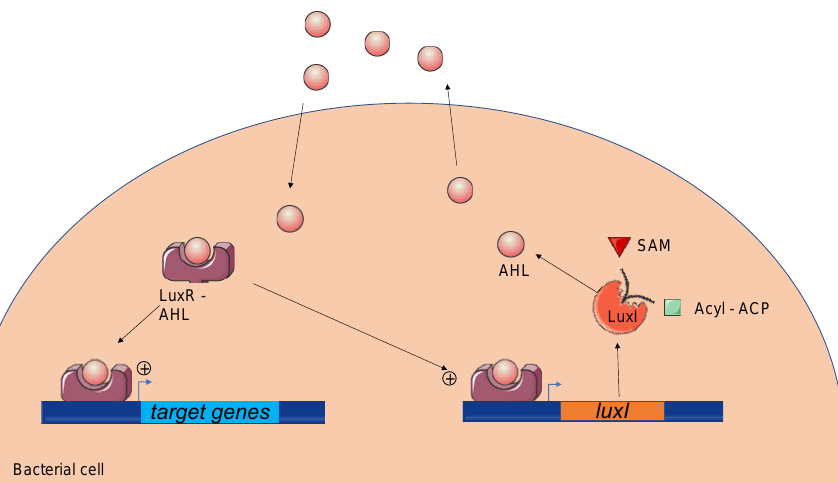
Figure 2. The N -acyl-homoserine lactone-mediated quorum sensing system. A LuxI-like synthetase forms an amide bond between a fatty acyl chain and an S -adenosylmethionine (SAM) to produce AHLs. Acyl–Acyl carrier protein (ACP). At a low cell density, AHLs are diluted in growth medium, whereas at a high cell density, AHLs accumulate and reach a threshold. Signal molecules diffuse across the cell envelope and bind to the LuxR-like regulator. Then, the LuxR–AHL complex regulates the expression of target genes such as luxI. Genes encoding the LuxI and LuxR protein families have different names depending on the strain and the species, with some variations in their functions. Table 2. Overview of AHL-mediated quorum sensing molecules produced by phytopathogenic bacteria.